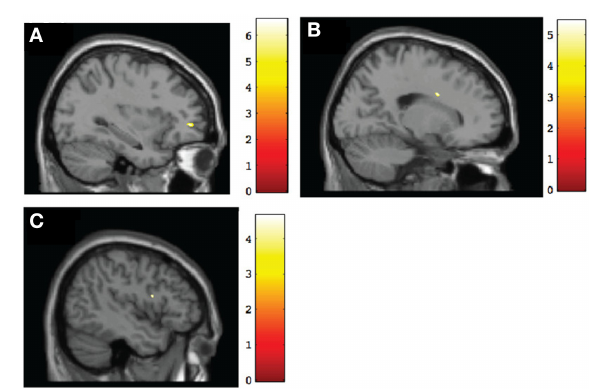
FIGURE 3 | Sagittal view of regions involving significant within-group increases of gray matter volume at post-intervention. (A) TX group, left middle frontal gyrus (BA10) [ − 32, 47, 0], p < 0 . 001, uncorrected; (B) DTC group, right cingulate gyrus (BA24) [19, 4, 30], p < 0 . 001, uncorrected; (C) CT group, left inferior frontal gyrus (BA9) [ − 45, 6, 18], p < 0 . 001,